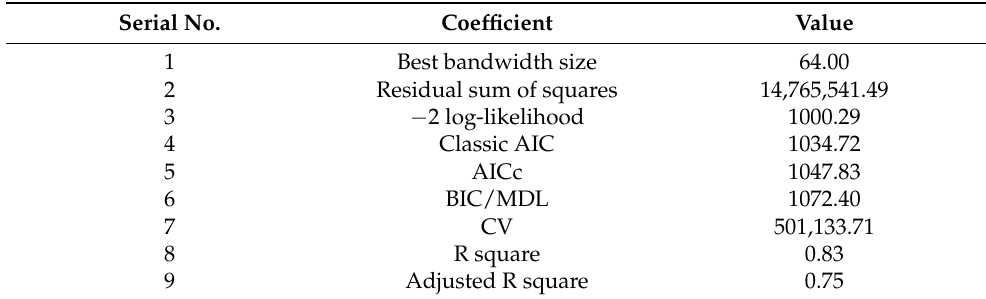
Table 5. Coefficient estimation of GWR model.